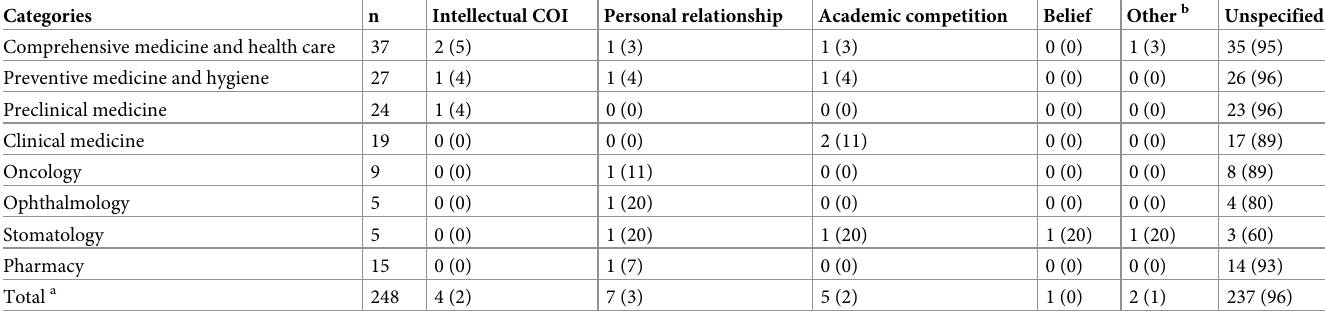
Table 5. Specific items of nonfinancial COIs in research [n